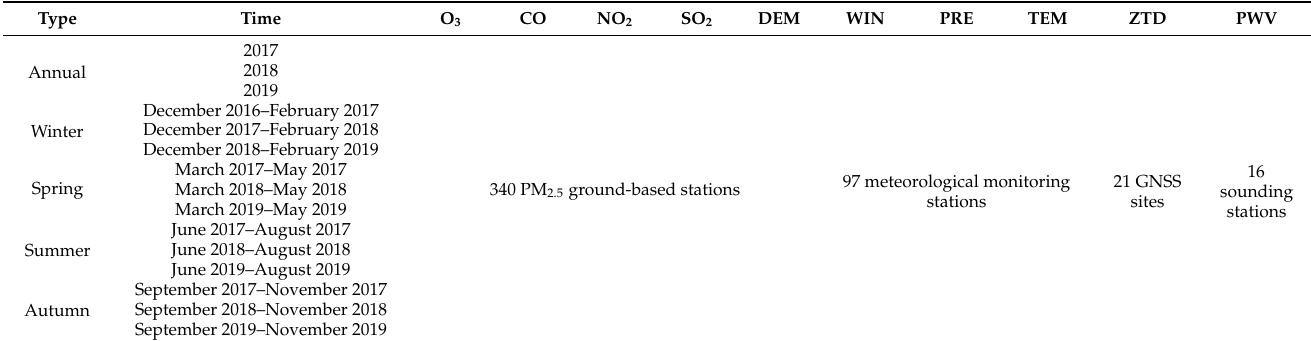
Table 1. Site Data